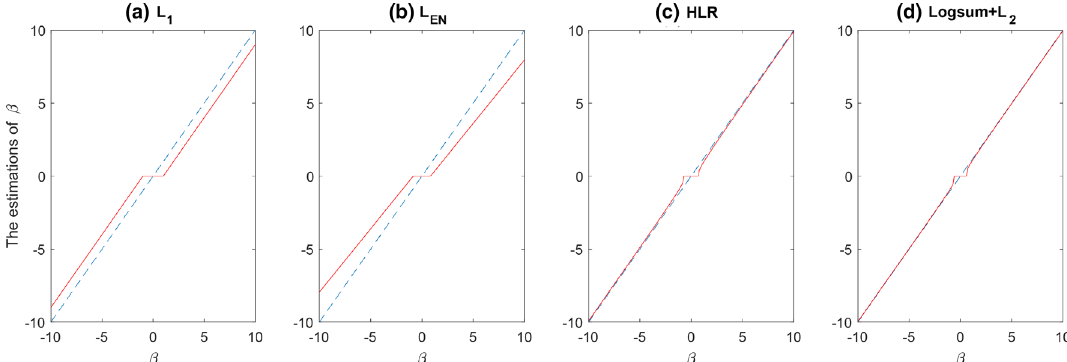
Figure 2. Exact solution of ( a ) L 1 ( b ) L EN ( c ) HLR ( d ) LogSum + L 2 in an orthogonal